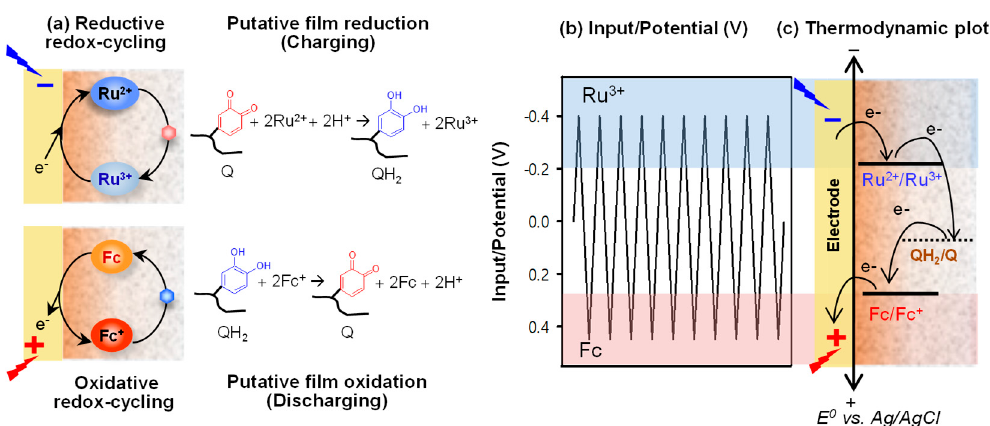
Figure 3. Proposed redox-cycling mechanism of redox-capacitor. ( a ) The reductive redox-cycling reaction of Ru 3+ can reduce the quinone moieties (charge, QH 2 ) and the oxidative redox-cycling reaction of ferrocene dimethanol (Fc) can oxidize the catechol moieties (discharge, Q). ( b ) Electrical input potential. ( c ) Thermodynamics requires electrons to be transferred from more reducing (more negative) potentials to more oxidizing (more positive) potentials.